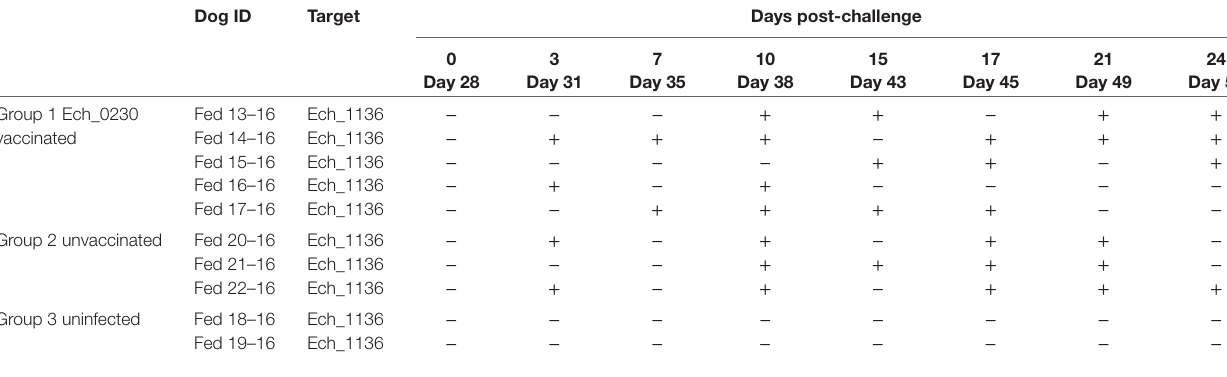
TaBle 2 | Infection status of dogs in groups 1–3 following wild-type Ehrlichia chaffeensis challenge. Dog